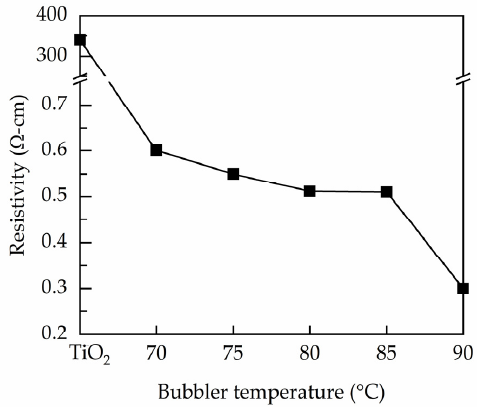
Figure 6. Four-point probe resistivity of the PEALD Ta-doped TiO 2 films prepared at different bubbler temperature.